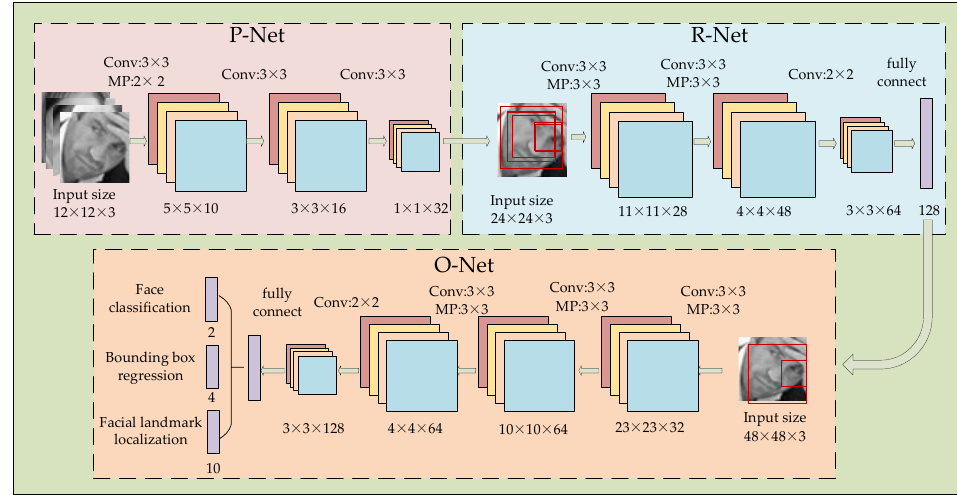
Figure 3. MTCNN network